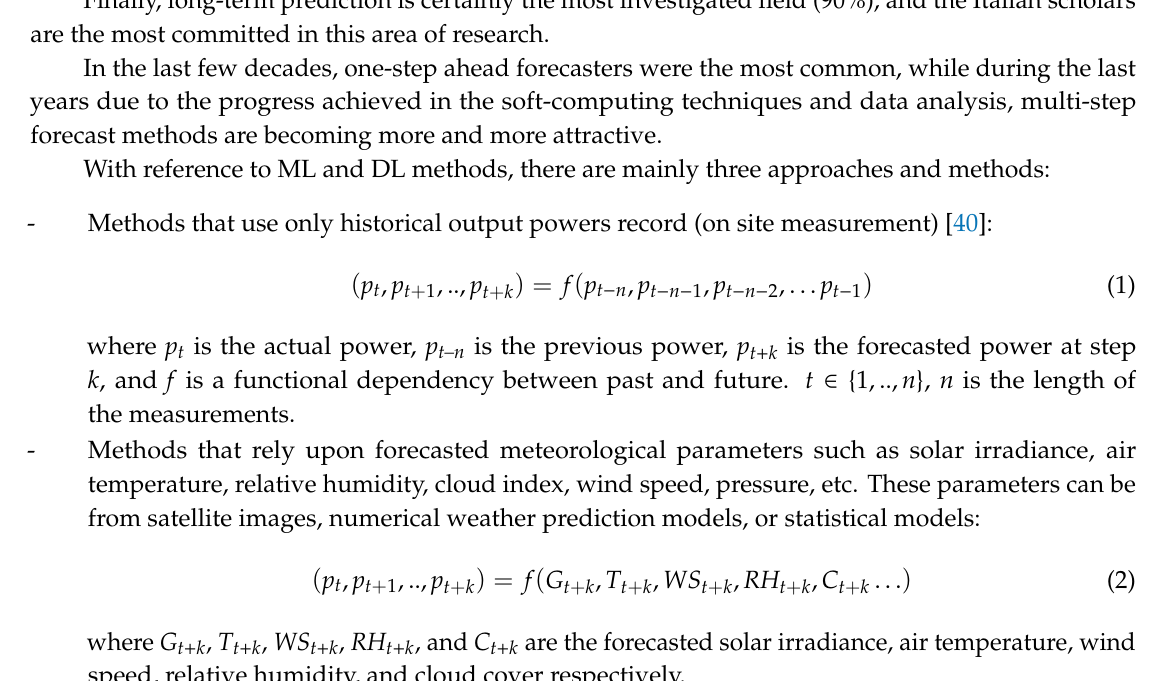
Figure 2. ( a ) AI-based PV power forecasting method; ( b ) the most common deep learning (DL)-techniques; ( c ) investigated time scale horizons, and ( d ) countries involved in PV forecasting.